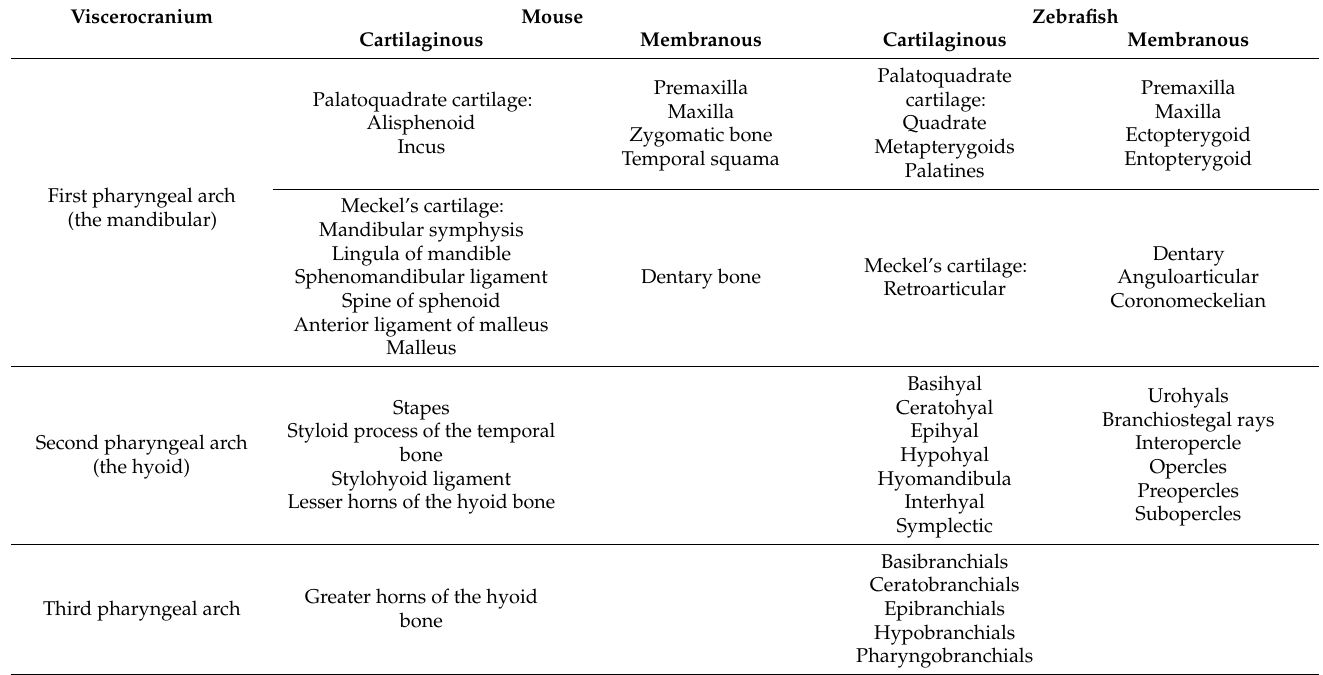
Table 1. Skeletal derivatives of PAs in the mouse and